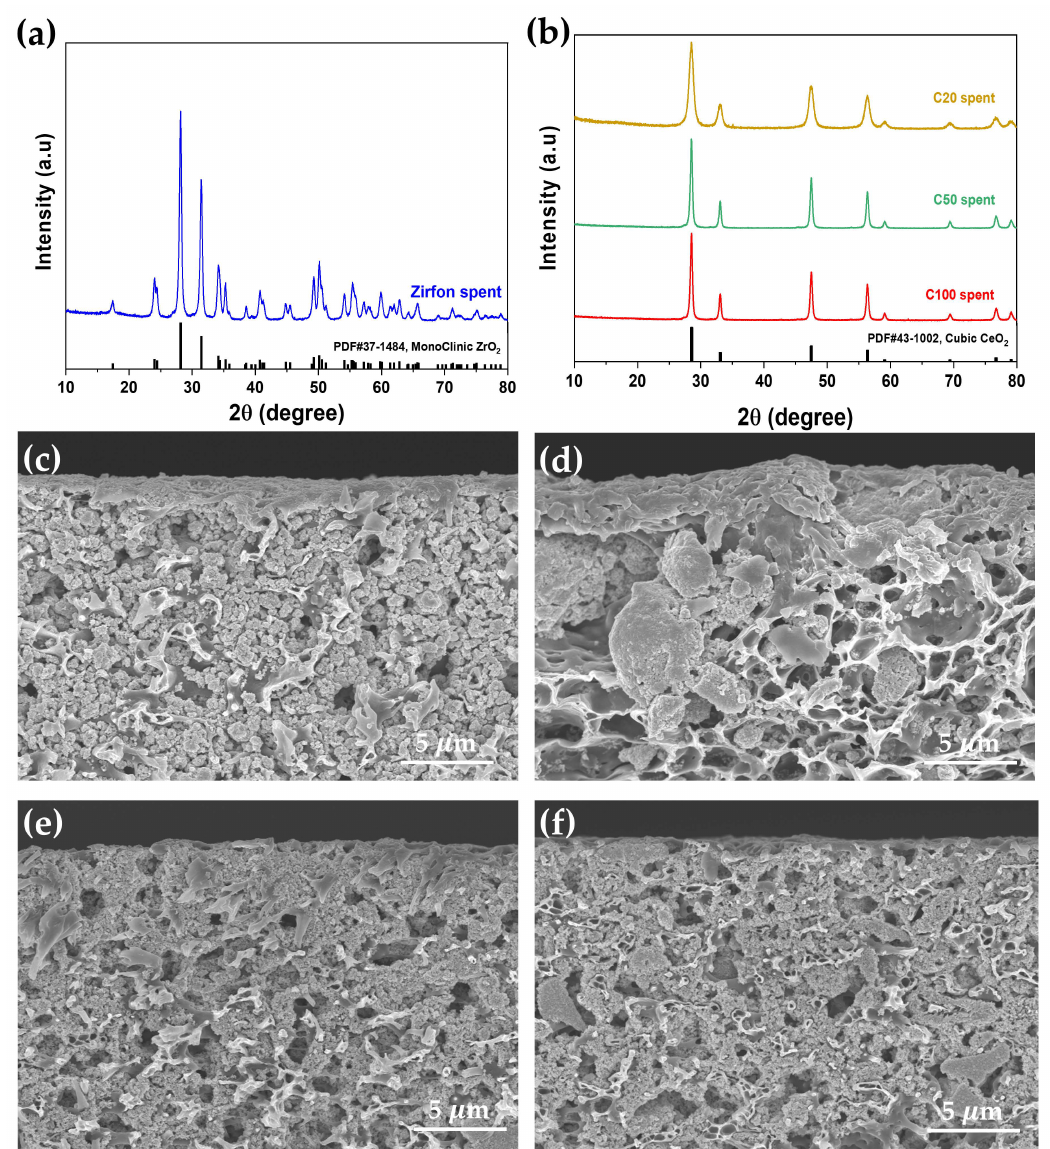
Figure 6. XRD patterns of spent ( a ) Zirfon separator, ( b ) CeO 2 -based separators, including C20, C50 and C100, and cross-section SEM images of spent ( c ) Zirfon separator, ( d ) C20 separator, ( e ) C50 separator and ( f ) C100 separator. The “spent” represent the separator after electrochemical test up to 2000 mA cm -2 at 30 wt% KOH and 80 ◦